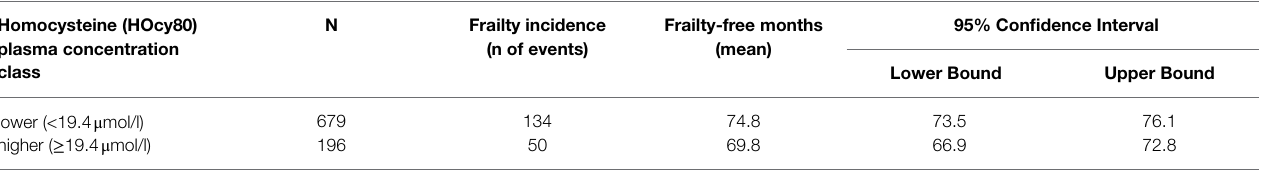
TABLE 5 | Frailty-free survival time according to HOcy80 plasma concentration. Homocysteine (HOcy80) plasma